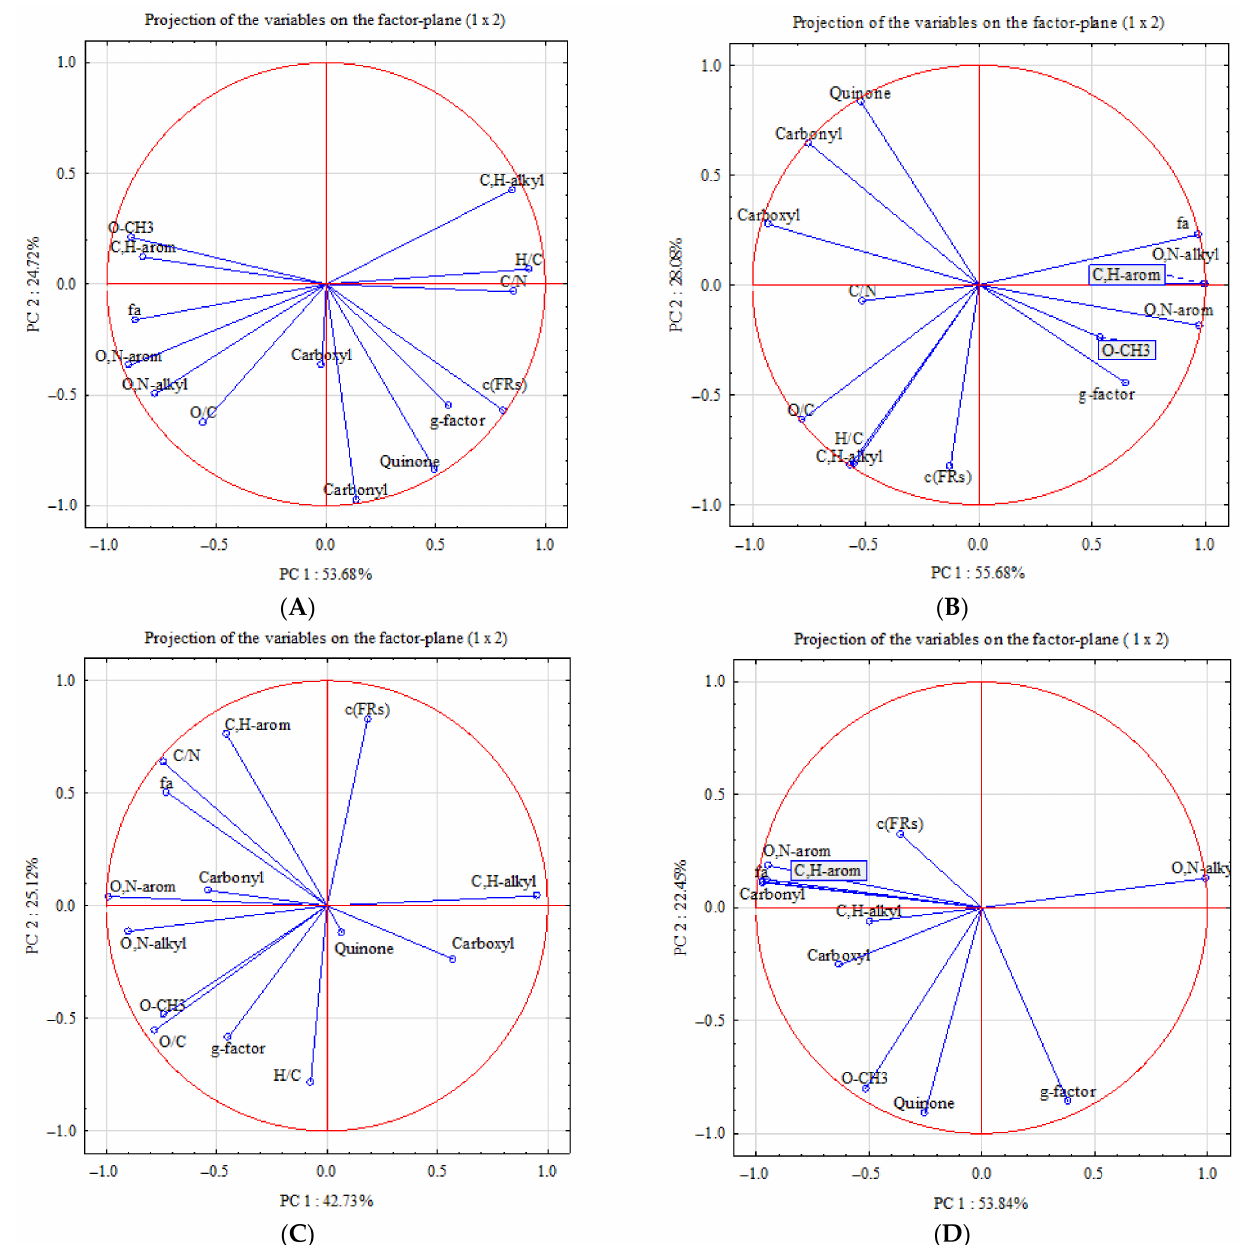
Figure 3. Projection of the HSs parameters using PCA: taiga HAs ( A ) and FAs ( B ); tundra HAs ( C ) and FAs ( D